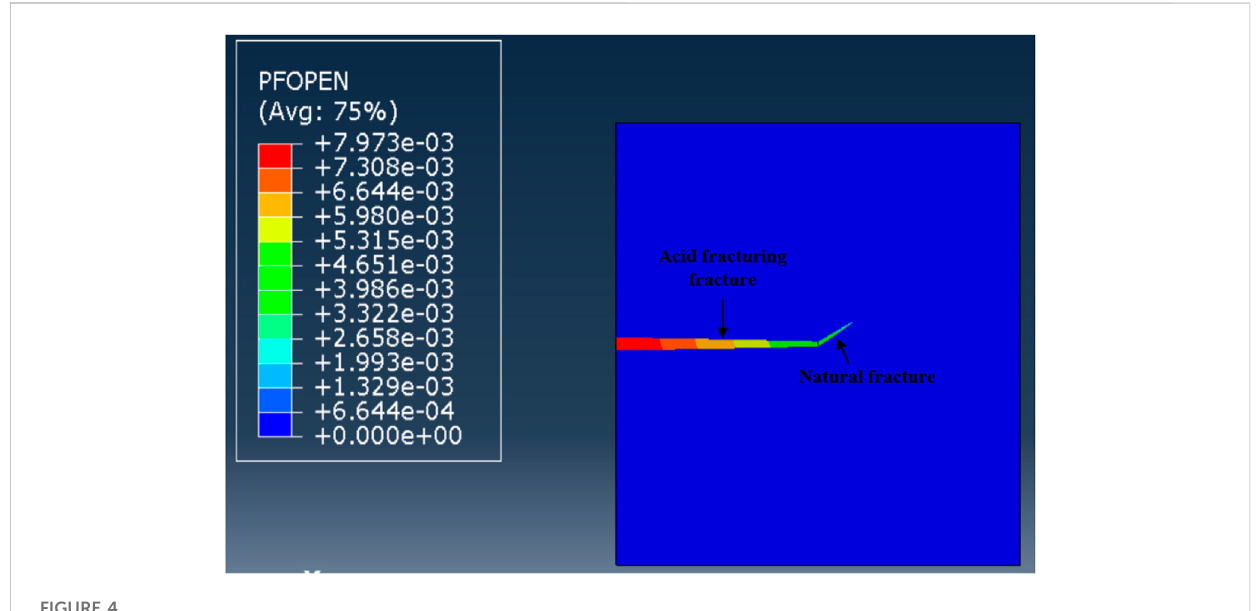
FIGURE 4 Simulation results of acid fracturing fracture